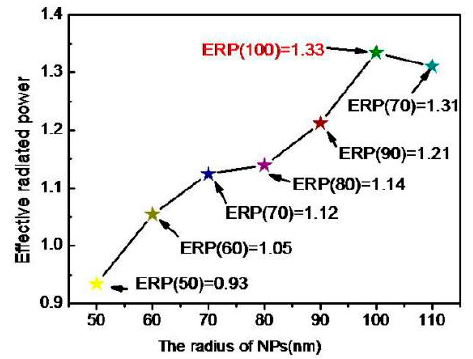
Figure 3. The effective radiated powers of seven kinds of Ag NPs under 600 nm light wave radiation by finite-difference time-domain method (FDTD) simulation.